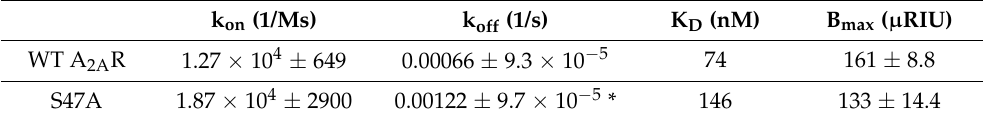
Figure 3. Specific binding of purified A 2A R and variants to purified G α s . SPR sensorgram curves show specific association and dissociation of 267, 445, and 667 nM (light gray, medium gray, dark gray, respectively) of purified ( A ) A 2A R, ( B ) S47A, and ( C ) W129A to purified G α s bound to a Ni- NTA sensor chip, as described in materials and methods. Mean ± S.D. from n = 6 (duplicates of 3 biological replicates). Table 2. Kinetic parameters determined from a one-one model of binding of purified receptor association to purified Gα s protein via SPR data shown in Figure 3. K D and B max values reported as best fit ± S.E. * Indicates p = 0.002.